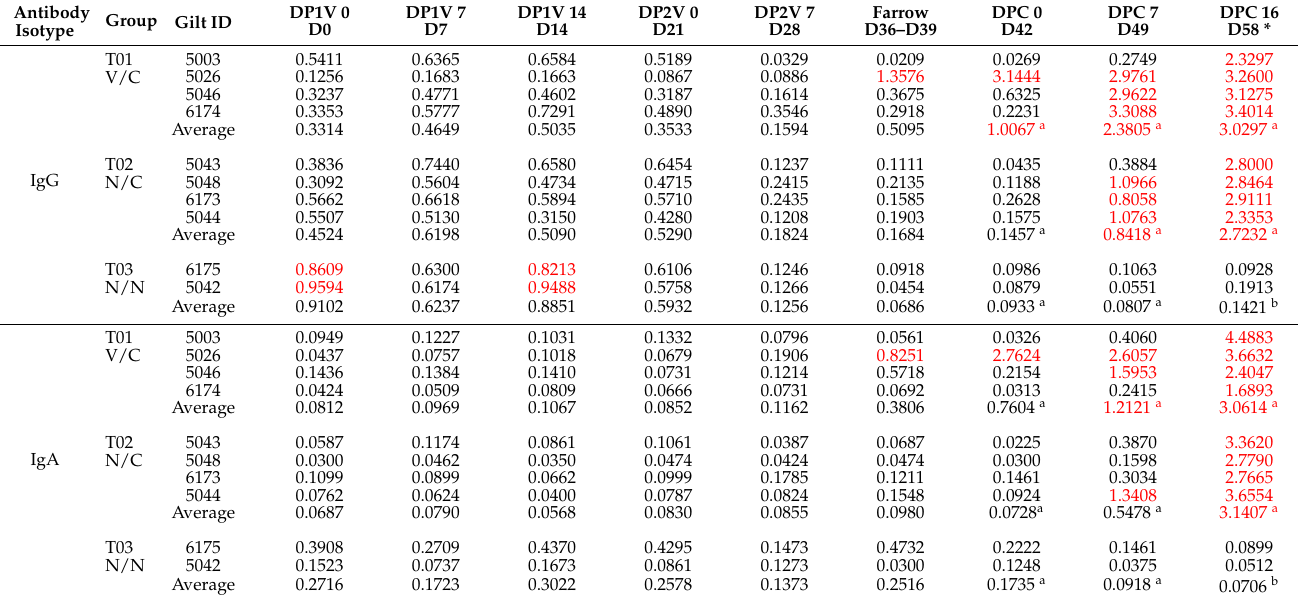
Table 2. Gilt anti-PEDV IgG and IgA response in serum as tested by PEDV whole virus-based ELISA (S/P ratios shown in the